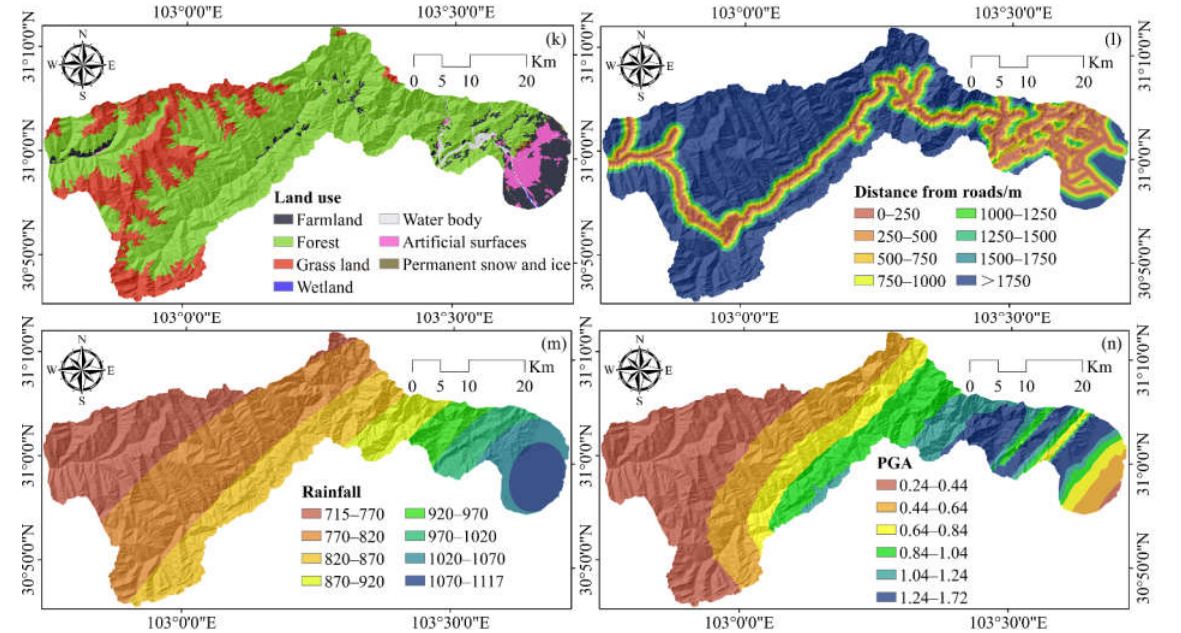
Figure 3. Landslide-related variables. ( a ) altitude, ( b ) slope angle, ( c ) slope aspect, ( d ) curvature, ( e ) lithology, ( f ) distance from faults, ( g ) distance from rivers, ( h ) SPI, ( i ) TWI, ( j ) NDVI, ( k ) land use, ( l ) distance from roads, ( m ) rainfall, and ( n ) PGA.